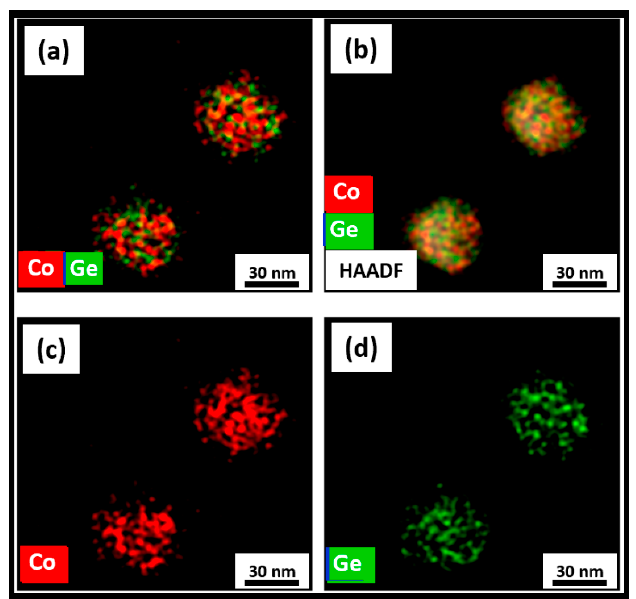
Figure 11. STEM studies on the further annealed Co 2 Ge NPs and EDS elemental color mappings showing: ( a ) Co and Ge distributions; ( b ) Co and Ge distributions with a HAADF image; ( c ) Co; and ( d ) Ge.